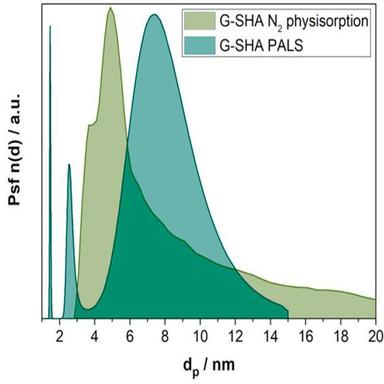
Normalized PSDs according to nitrogen physisorption (NLDFT) and PALS for biogenic silica derived from spelt husk (Germany).